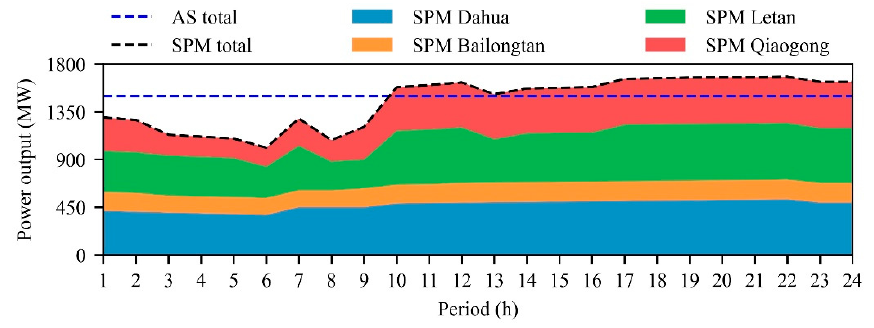
Figure 7. Comparsion of power output results of SPM and AS.